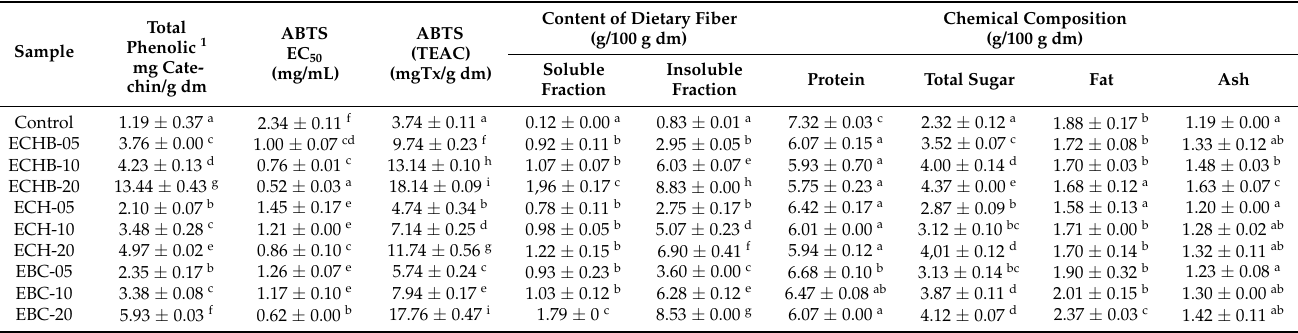
Table 3. Chemical composition and total phenolic content, antioxidant activity, and dietary fiber content of corn extrudates with fruit